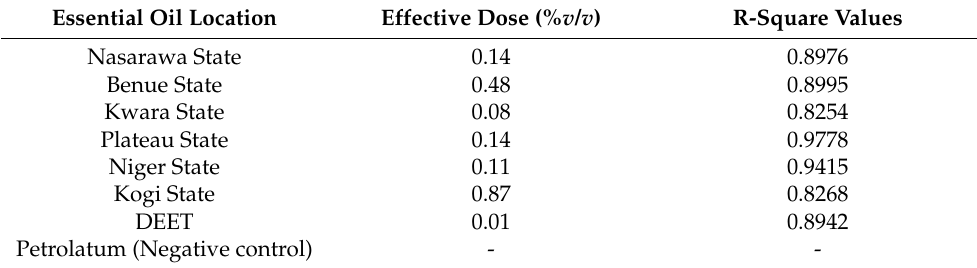
Table 4. Effective does (% v / v ) of essential oil from the six states and N , N -diethyl-3-methylbenzamide. Essential Oil Location Effective Dose (% v / v ) R-Square